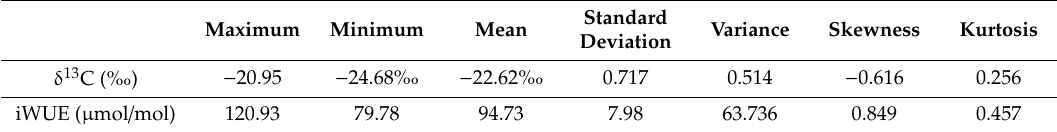
Table 1. The statistical characteristics of tree-ring δ 13 C and iWUE (1850–2008).